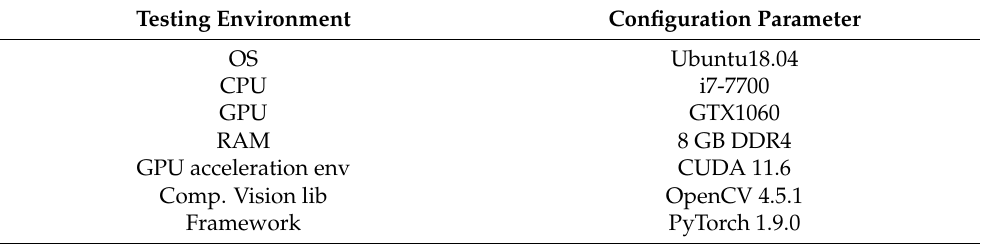
Table 1. Local computing resources and CNN